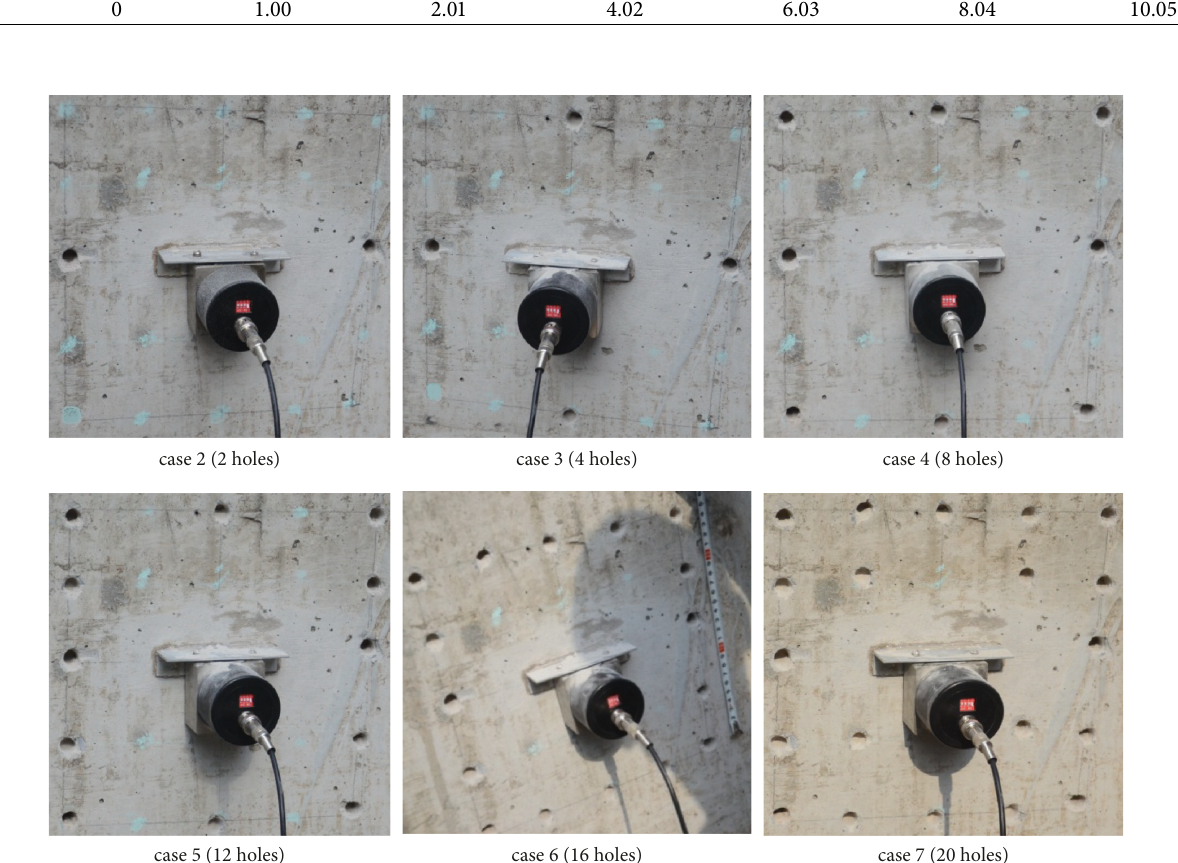
Figure 4: Partial damage: case 2 (2 holes), case 3 (4 holes), case 4 (8 holes), case 5 (12 holes), case 6 (16 holes), and case 7 (20